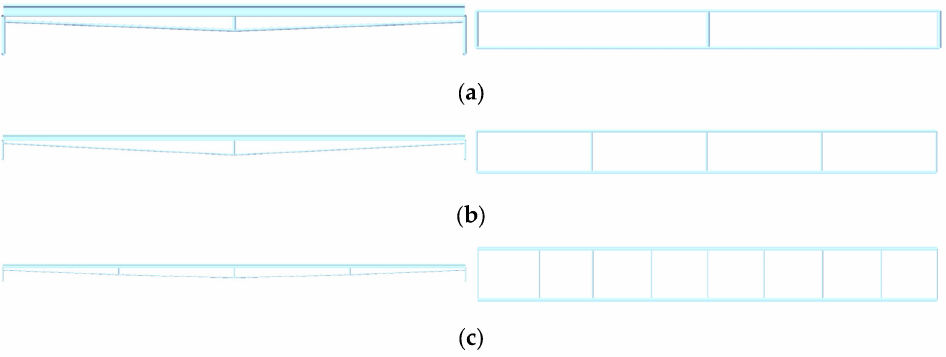
Figure 8. Finite element model of three spans. ( a ) 5 m span finite element model, ( b ) 10 m span finite element model, ( c ) 15 m span finite element model.